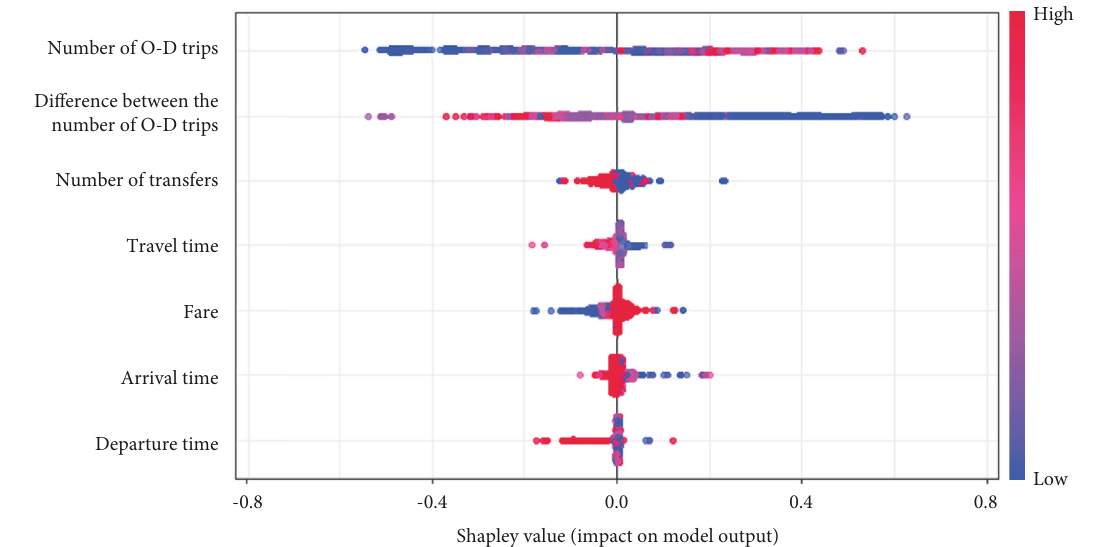
Figure 4: Results of the Shapley values of nine